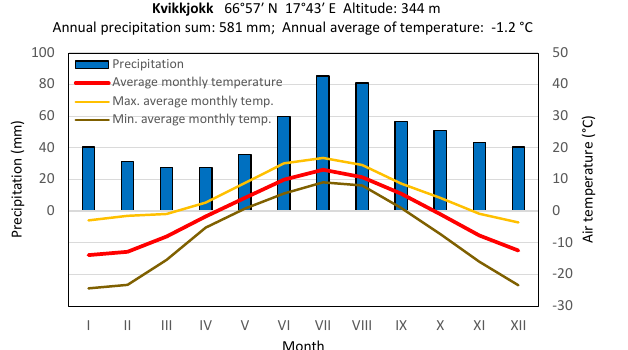
Figure 2. Walter climate diagram for the station Kvikkjokk (time period